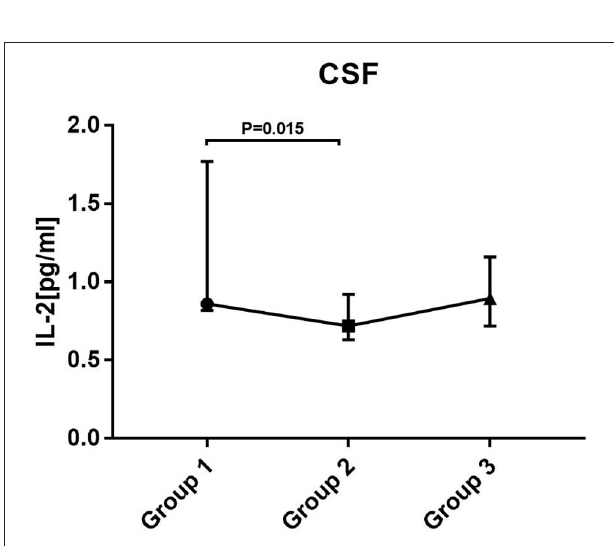
FIGURE 3 | Levels of cytokines/chemokines in patients at different stages of disease. Kruskal–Wallis test with Mann–Whitney U test for post hoc analysis and Bonferroni correction were used. Only changes in IL-2 between group 1 and group 2 were statistically significant. Group 1: before treatment. Group 2: treatment had lasted for 2–3 months (the intermediate stage of treatment). Group 3: treatment had lasted for more than 3 months (the late stage of